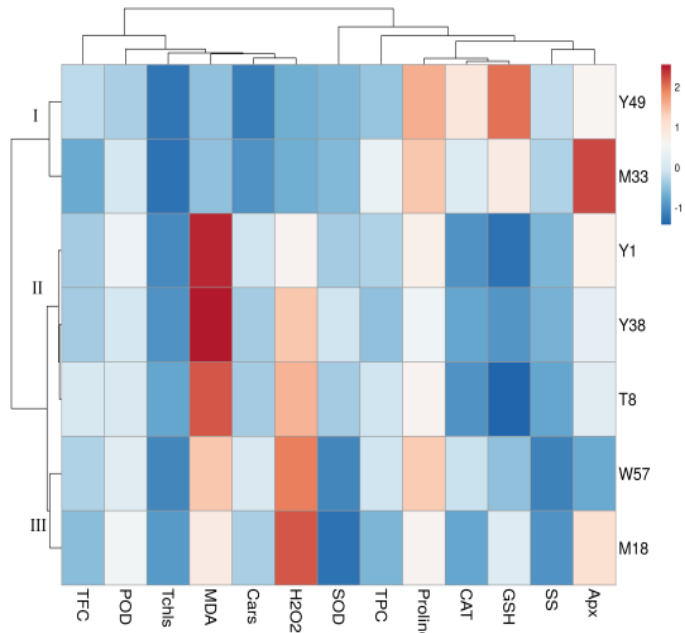
Figure 6. Cluster heat map results were obtained based on biochemical parameters in cold stress conditions.